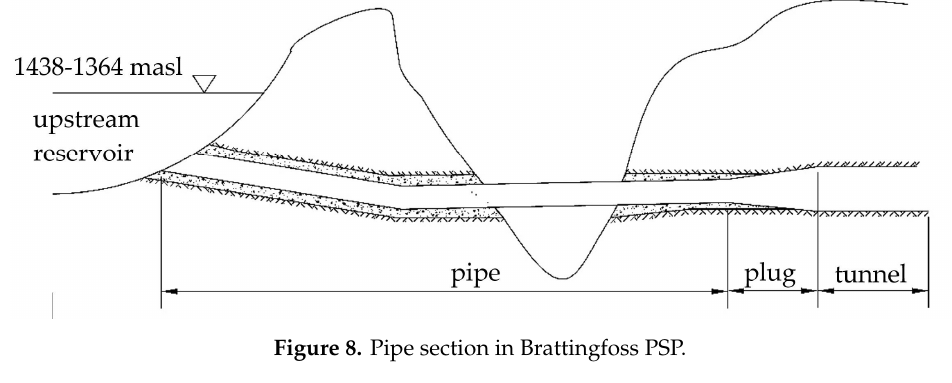
Figure 8. Pipe section in Brattingfoss PSP.